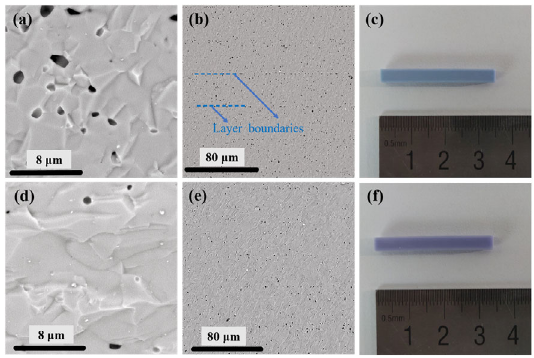
Fig. 8 (a–c) SEM images and optical pictures of the samples sintered at 1300 in the air and (d ℃ –f) wet CO 2 .